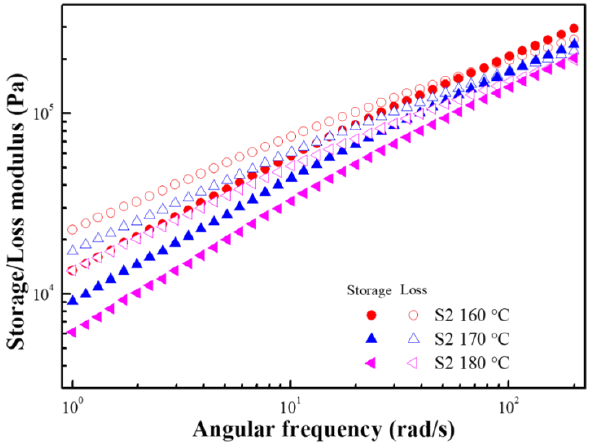
Figure 11. Frequency-dependent storage modulus (closed symbols) and loss modulus (open symbols) of S2 at various temperatures.